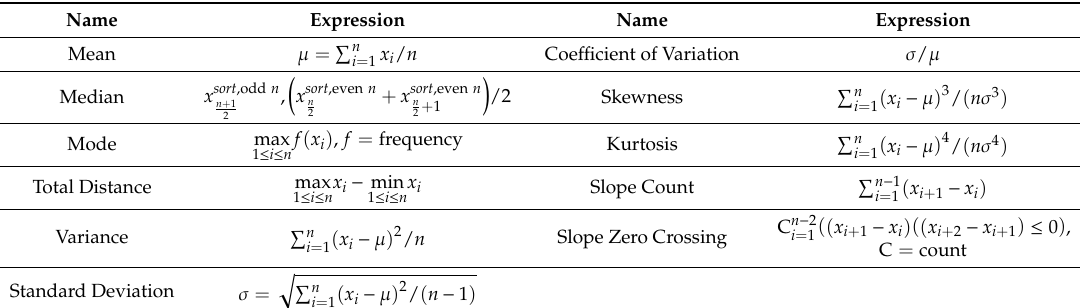
Table 4. Statistical features of gait signals.